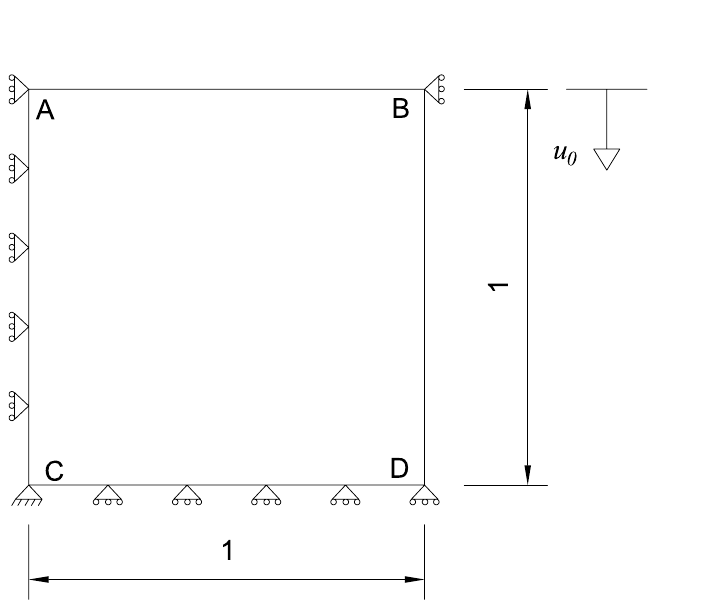
Table 7. The standard deviation of the structural capacity given by the HSGPR-based flow stress model and the target model at different dataset sizes, temperatures and coefficient of variation (COV).